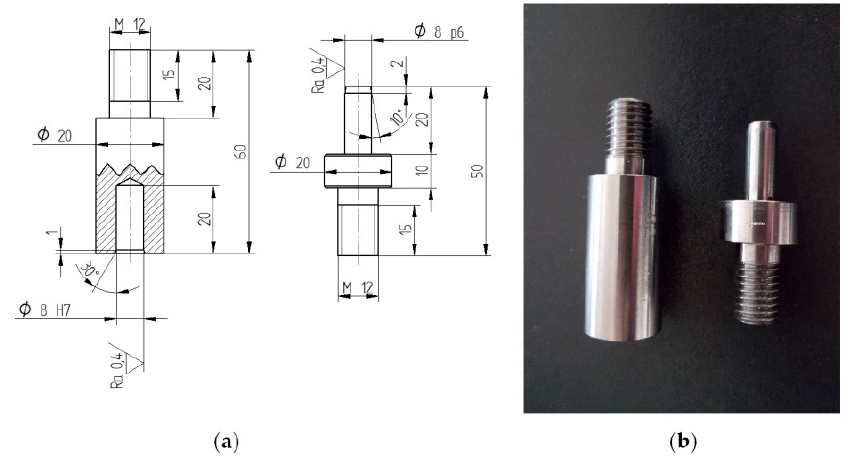
Figure 2. ( a ) Technical drawing of the joint, ( b ) Set before pressing.